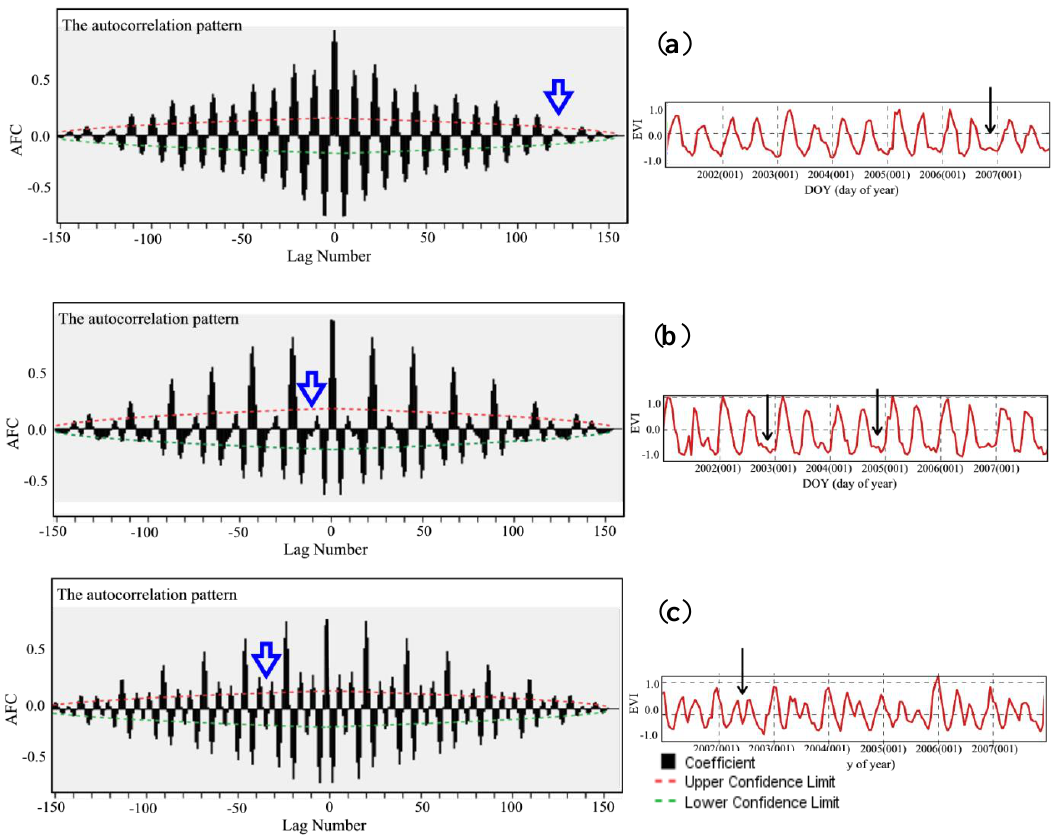
Figure 8. Autocorrelation patterns of intensive paddy fields in three specific areas. ( a ) Paddy field with double cropping system in upland area. ( b ) Paddy field with double cropping system in lowland area. ( c ) Paddy field with triple cropping